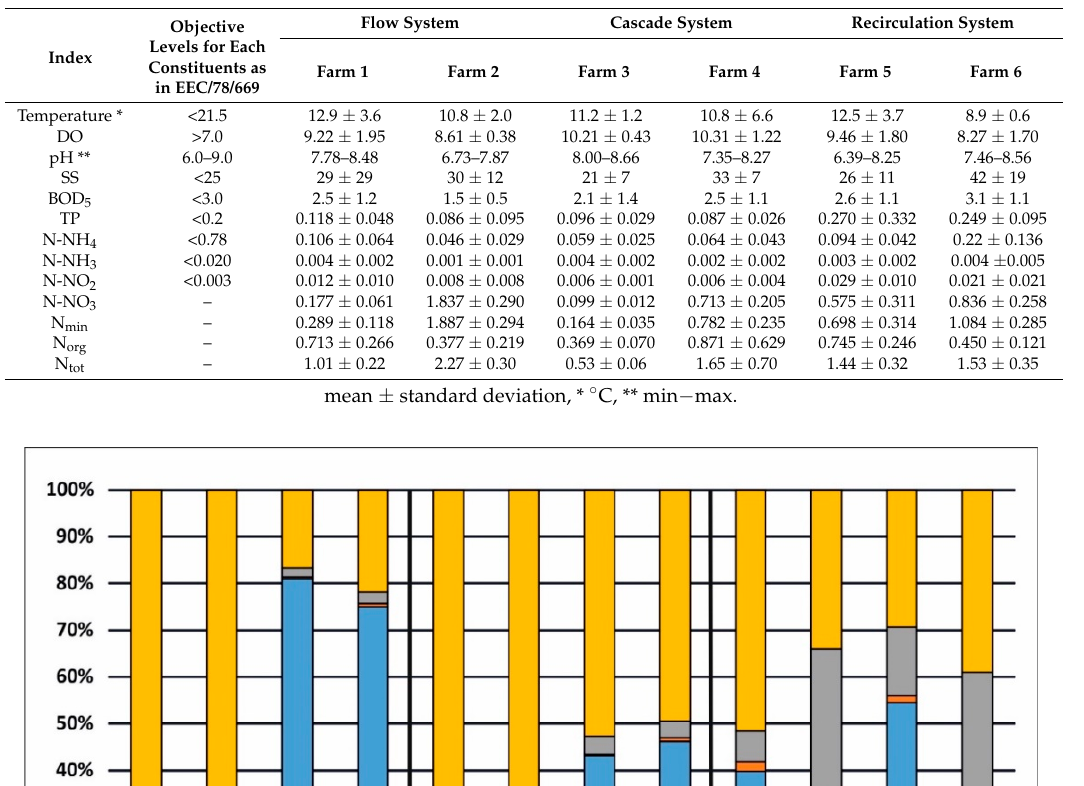
Table 2. pH value and mean concentrations of selected substances in waters inflowing to the analyzed fish farms (mg·dm − 3 ).